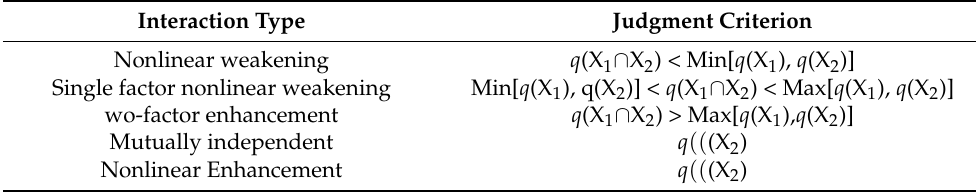
Table 2. Interaction classification criteria.